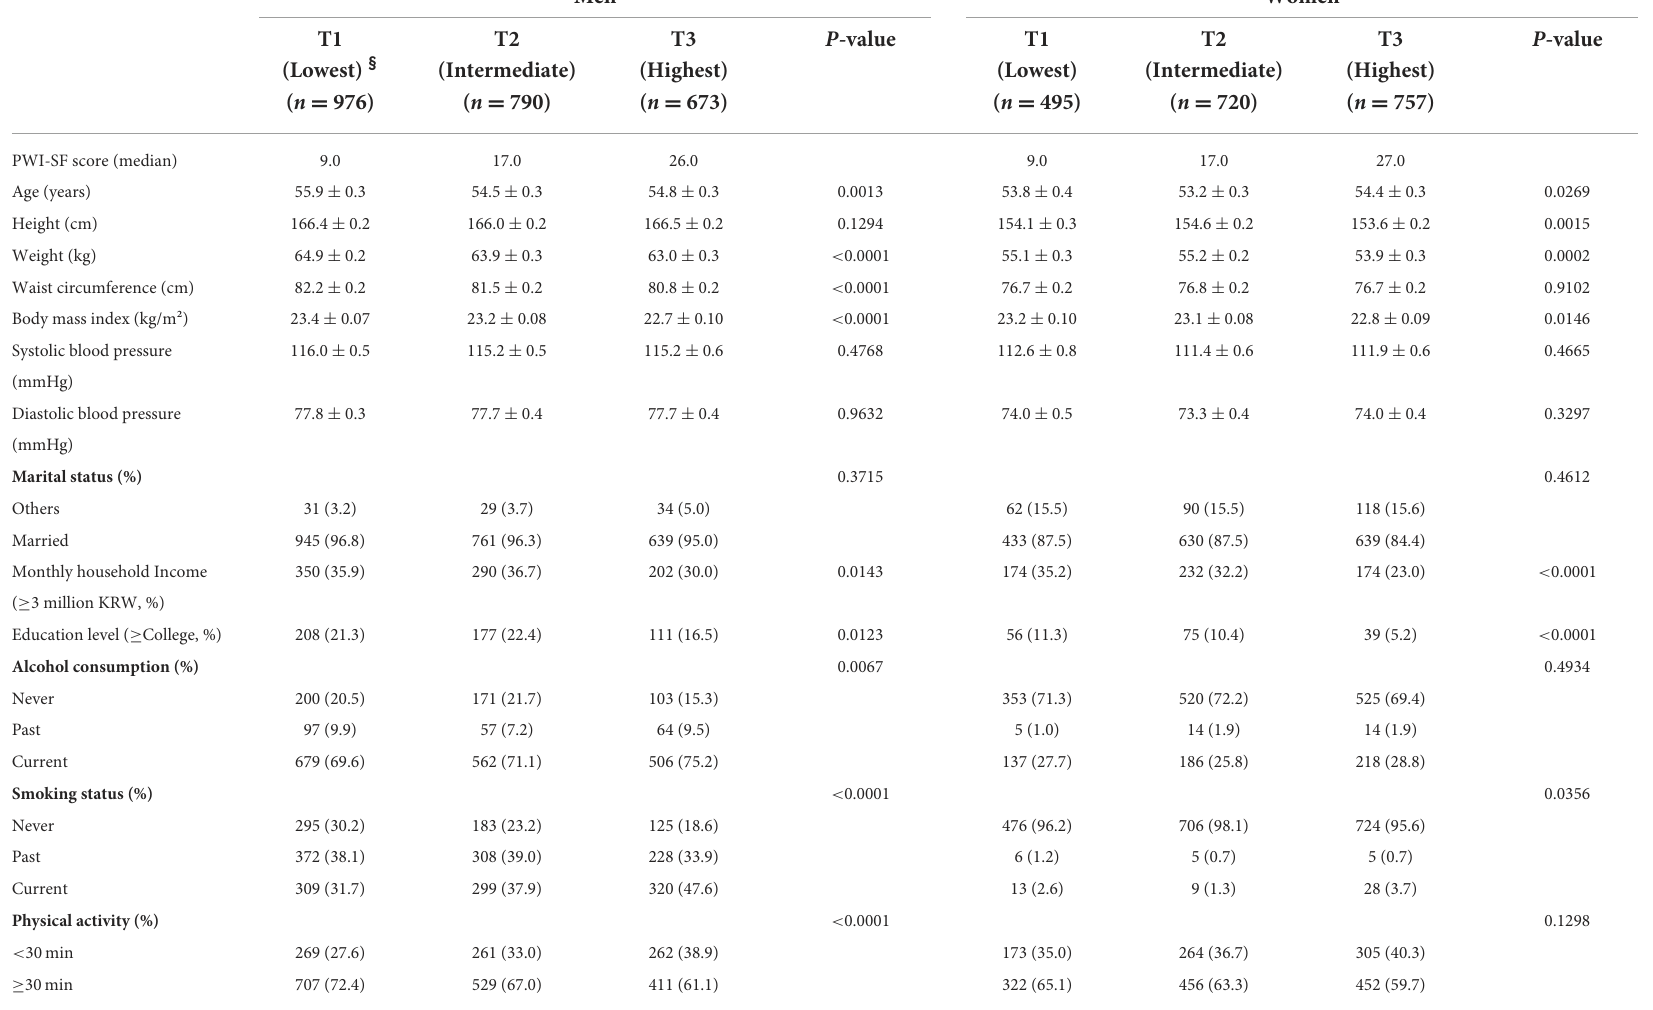
TABLE 1 Baseline characteristics of the study